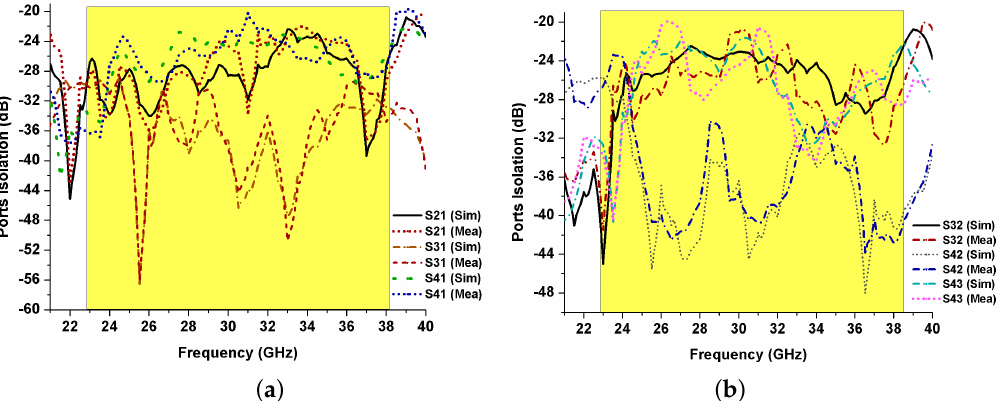
Figure 9. Proposed wideband MIMO antenna S-parameters at ( a ) port 1 and ( b ) other